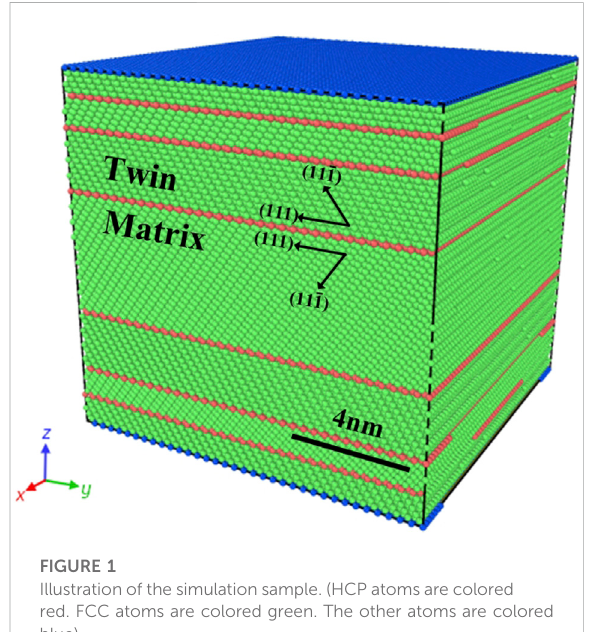
FIGURE 1 Illustration of the simulation sample. (HCP atoms are colored red. FCC atoms are colored green. The other atoms are colored